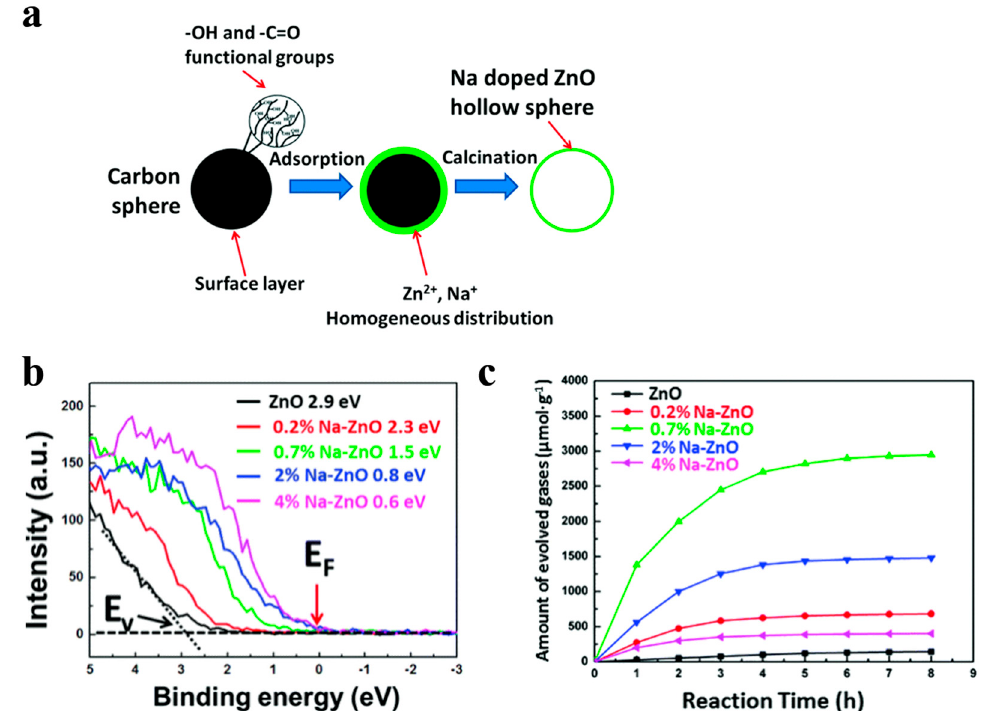
Figure 4. ( a ) Schematic route for preparing Na-ZnO hollow nanostructures, ( b ) valence band measure of Na-ZnO with various Na doping concentrations, ( c ) corrensponding H 2 generation for Na-ZnO/Pt hollow spheres with 0, 0.2, 0.7, 2, and 4 at % Na. Reproduced with permission from [53]. Copyright Royal Society of Chemistry, 2016.